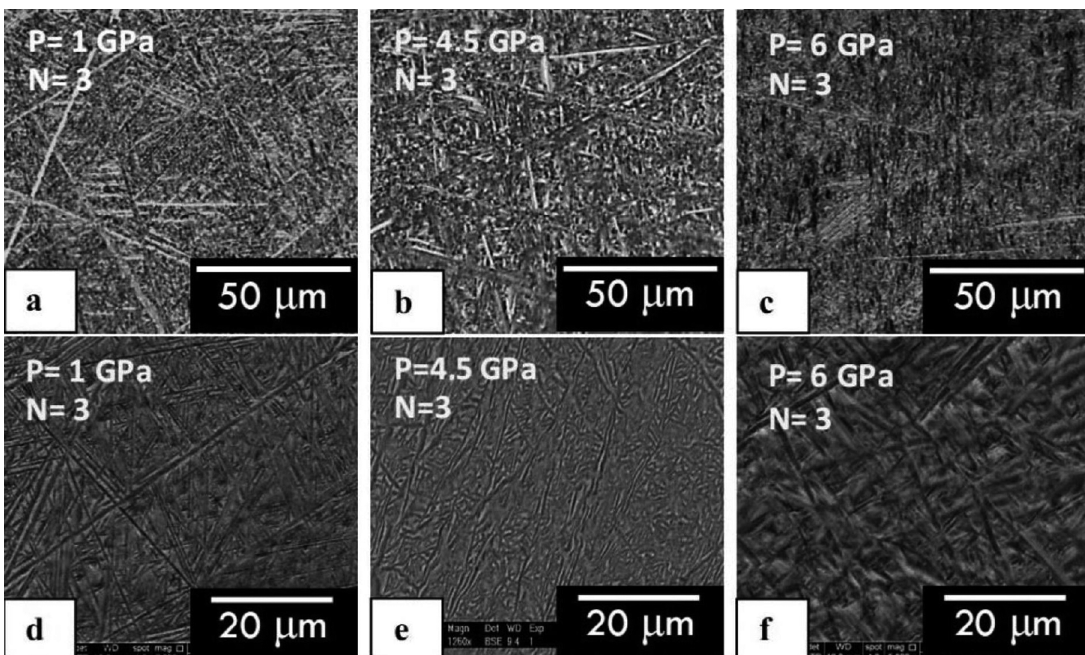
Figure 2. OM (a, b, c) and SEM (d, e, f) micrographs showing microstructures of the severely plastically deformed Ti-13Nb–13Zr alloy. The conditions are specified in the figures, where N means the number of